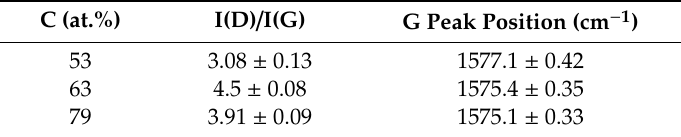
Table 4. Analysis of Raman spectra for tested coatings.